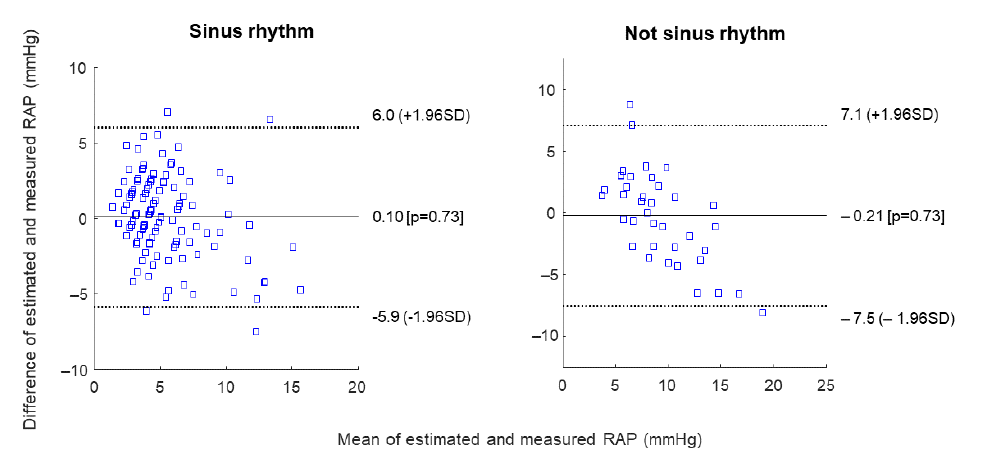
Figure A2. Bland–Altman plots comparing estimated (by LM) and measured RAP on our dataset split into patients with sinus rhythm or with irregular